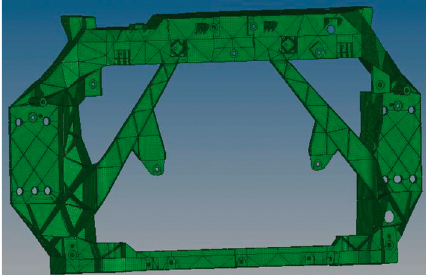
Figure 14: Grid of the middle surface of the front-end frame.